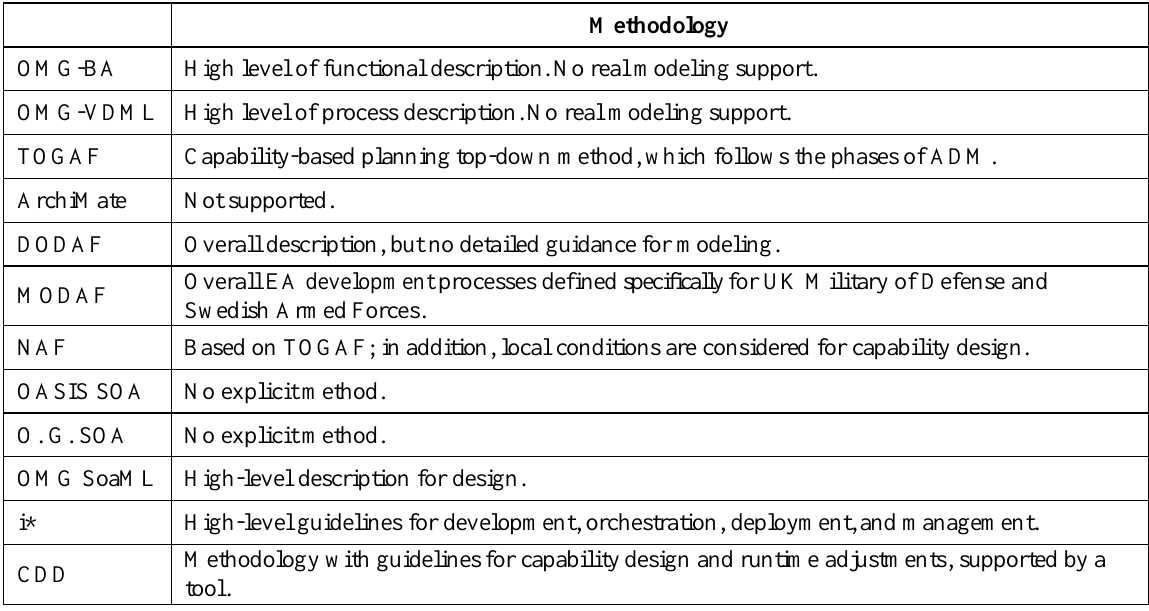
Table 4. The “Methodology” aspect of the capability concept